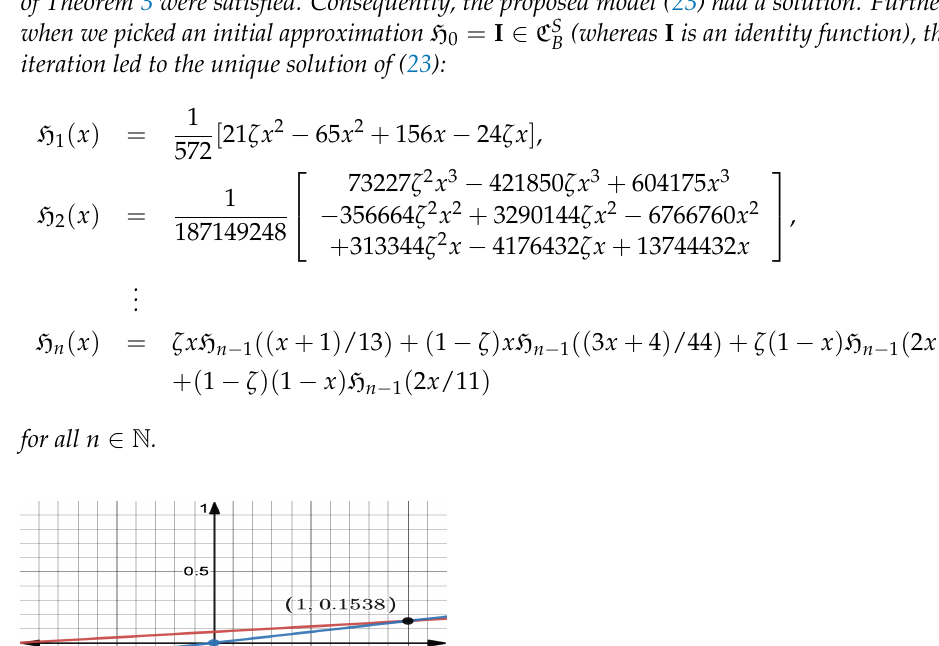
Figure 2. The graph of G γ